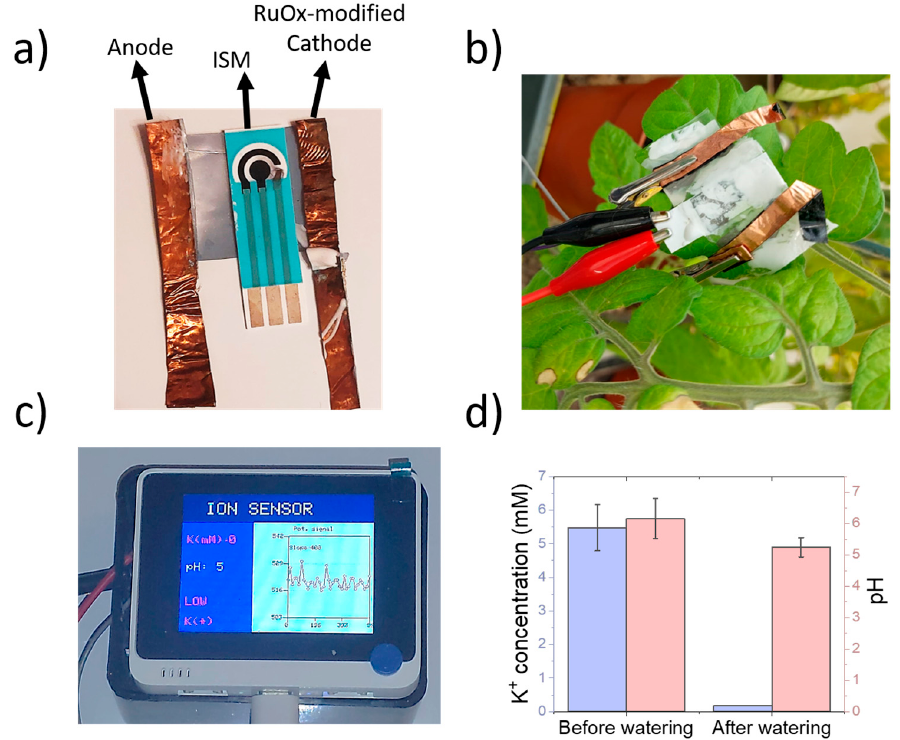
Figure 6. ( a ) Picture of sensing device, including a screen-printed three-electrode cell and copper electrodes for the iontophoretic extraction. Hydrogels were placed onto both electrodes and ISM. ( b ) The sensing device could be placed onto tomato leaves and connected to the microcontroller device using standard crocodile clips. ( c ) Designed user interface for experimentation and data visualisation using a microcontroller device. The potentiometric results are displayed in real time, and the average potassium and pH values are displayed. Non-healthy values of pH or K + are displayed in red. ( d ) Results obtained during the measurement of both K + and pH in tomato leaves before and after watering using DI water.